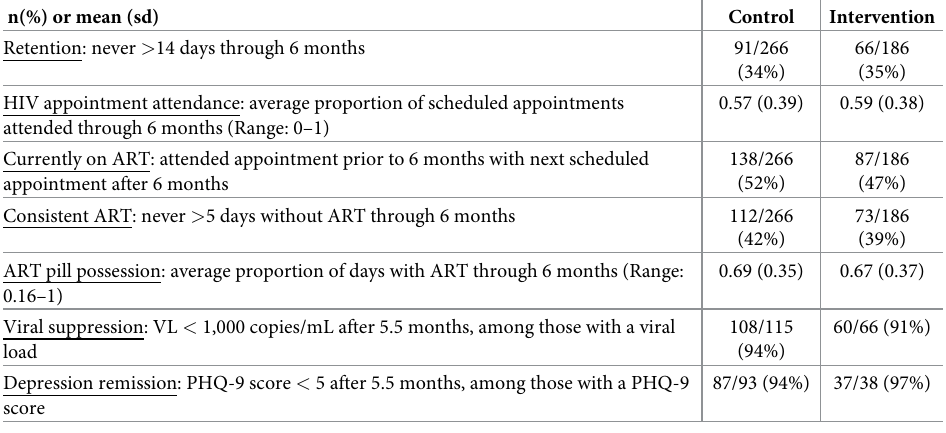
Table 5. Program impact on HIV and depression